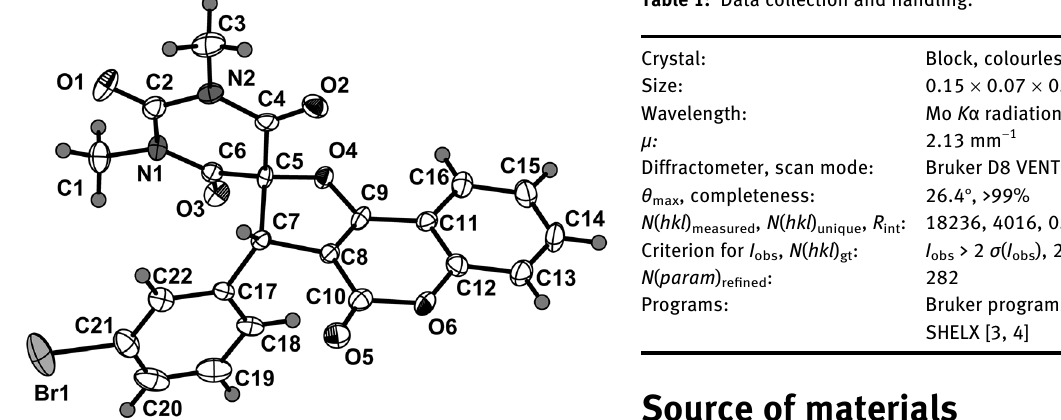
Table 1 contains crystallographic data and Table 2 contains the list of the atoms including atomic coordinates and displacement